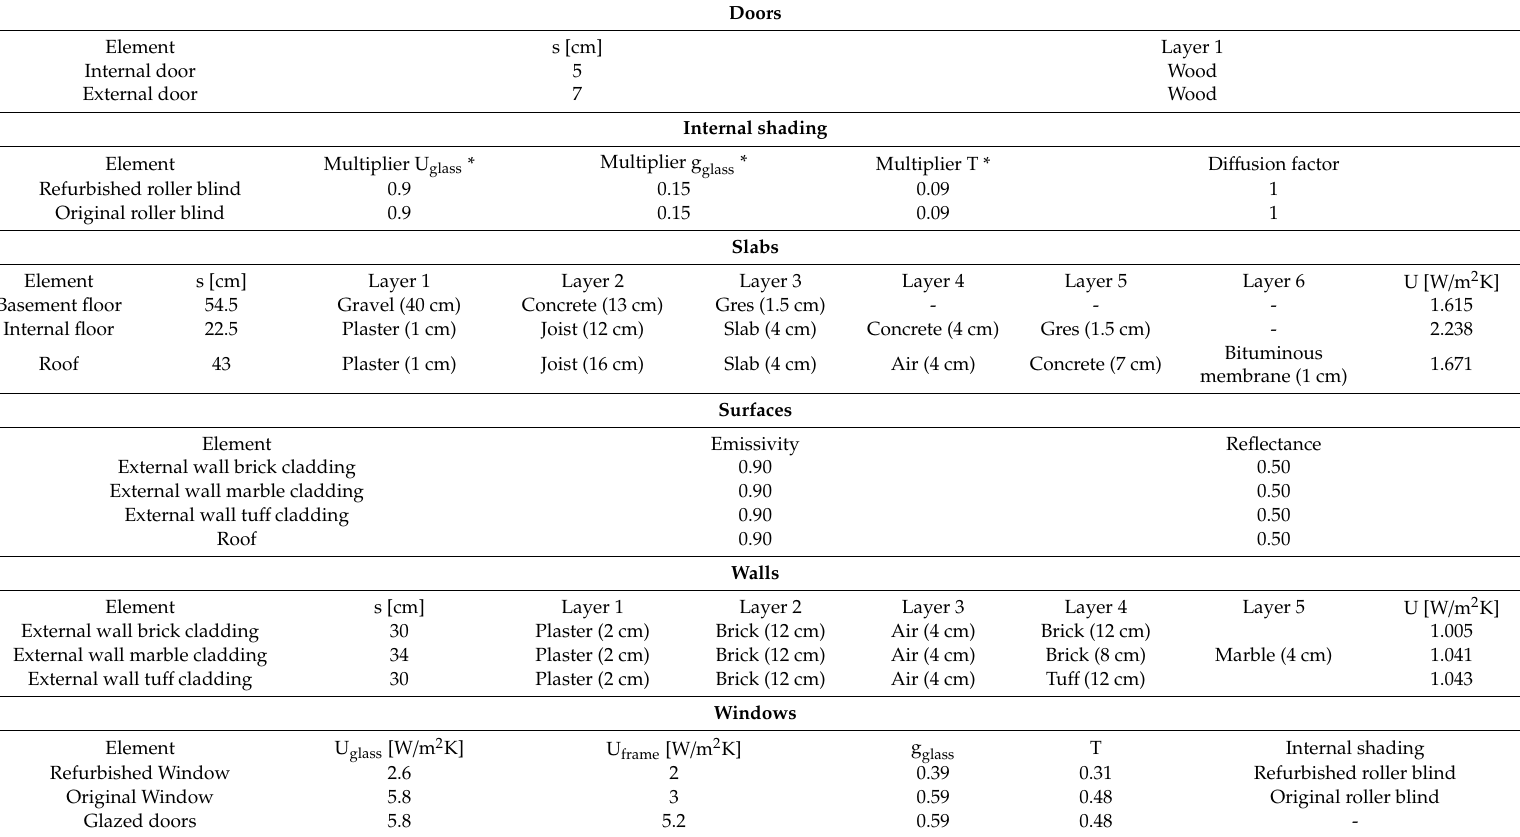
Table 4. Construction elements for first guess